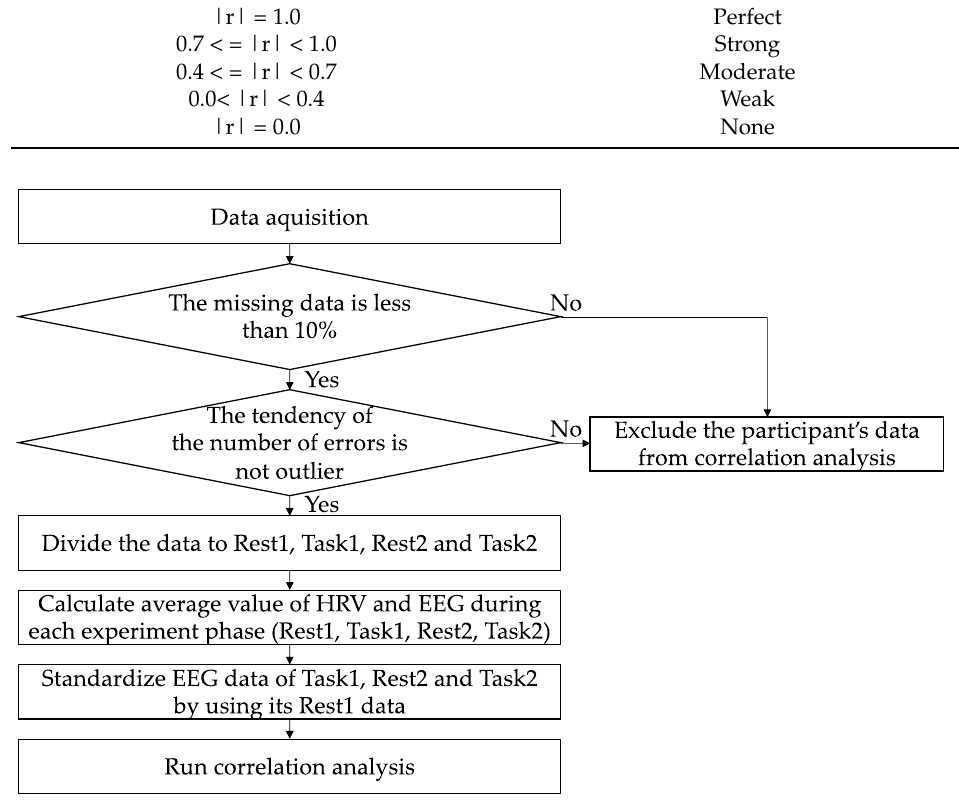
Figure 4. Flowchart of the data analysis method.